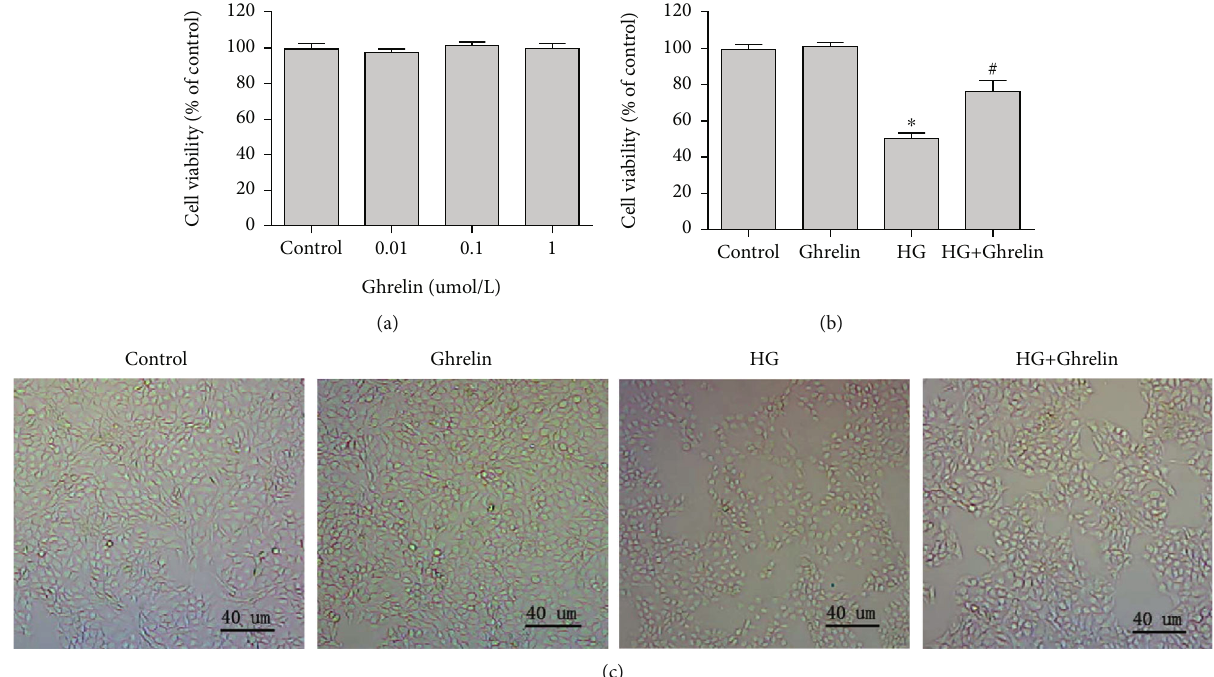
Figure 1: MTT assay for the survival rate of HLE cells. (a) HLE cells were treated with di ff erent concentrations of ghrelin (0 μ M, 0.01 μ M, 0.1 μ M, or 1 μ M) for 24 h. (b) Cells were pretreated with ghrelin (0.1 μ M) for 2h and then exposed to HG for 24h. (c) Morphological observation of HLE cells, about 400 cells were detected by light microscope in each picture. ∗ P < 0 : 05 vs. control group; # P < 0 : 05 vs. HG